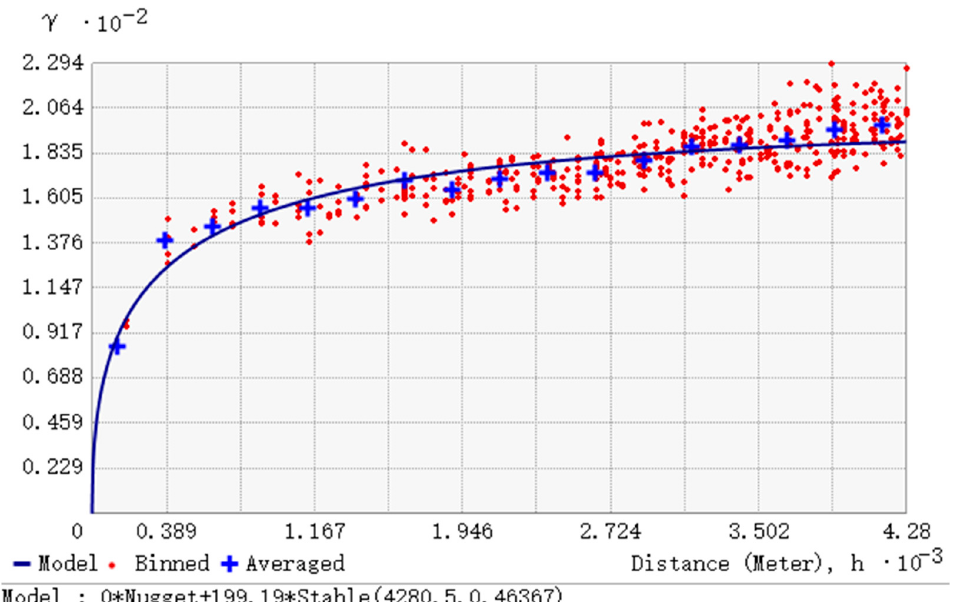
Figure 2. Semivariogram modelling of building height.